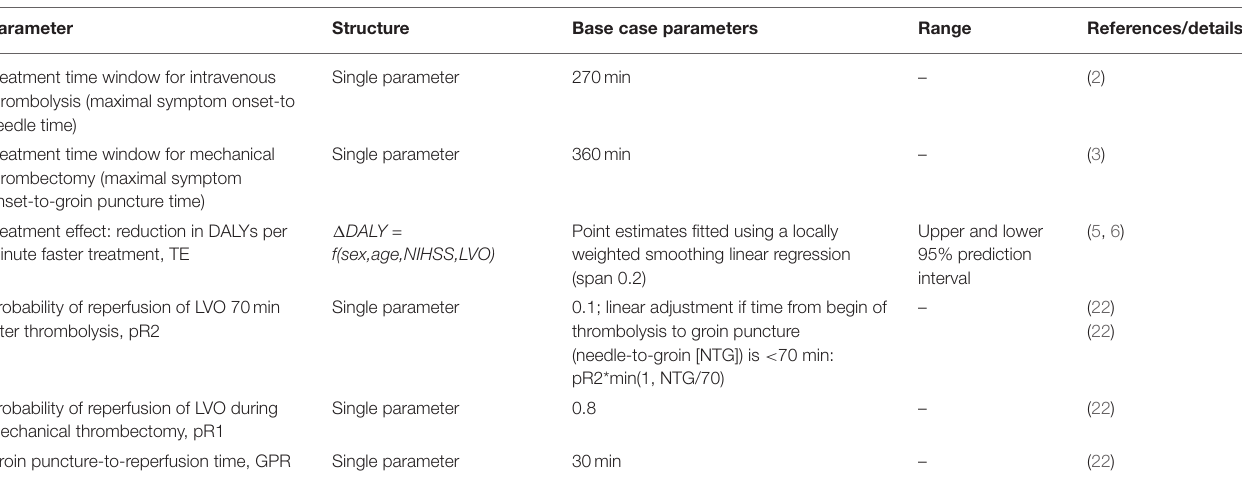
TABLE 3 | Treatment related parameters used in the model.